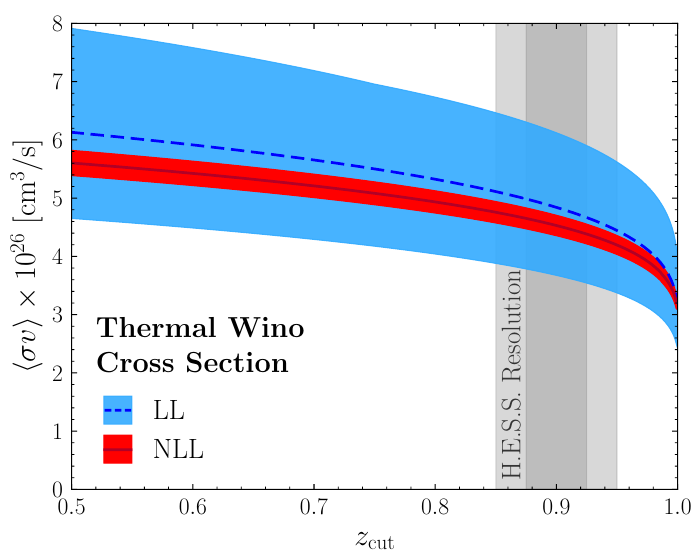
Figure 1 . The cross section for a thermal wino, i.e., with mass M (cid:31) = 2 : 9 TeV [32], as a function of resolution parameter z cut , showing our results at both LL and NLL. The NLL calculation signi(cid:12)- cantly reduces uncertainties as compared to LL. A region appropriate for the H.E.S.S. experimental resolution, which is 10% at these energies [33], is shown in the grey band. This band is represen- (cid:24) tative of the range of values that will contribute when our spectrum is convolved with the H.E.S.S. energy resolution